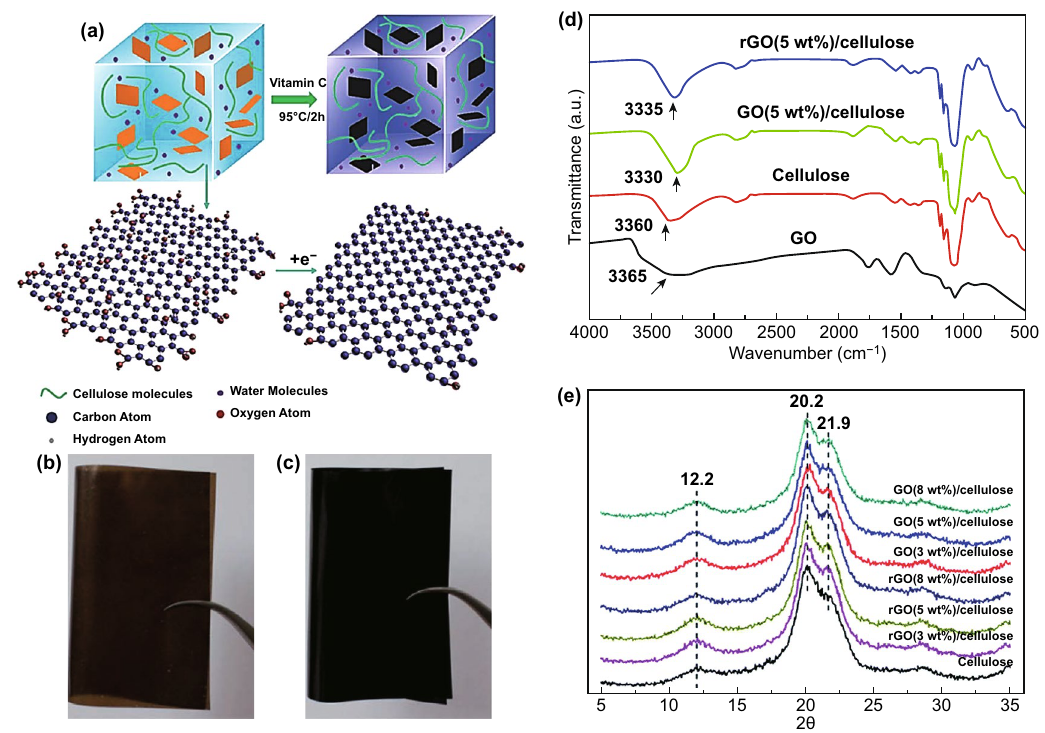
Fig. 12 a Schematic view of in-situ GO chemical reduction in NCs matrix with L-ascorbic acid solution (Vitamin C). b, c Regenerated iso- tropic-flexible brown NCs-GO and black NCs-rGO hybrid films. d, e XRD pattern and FTIR spectra of NCs, NCs-GO, and NCs-rGO nanocom- posites. Reproduced with permission from Ref. [32] Copyright © 2018, The Royal Society of